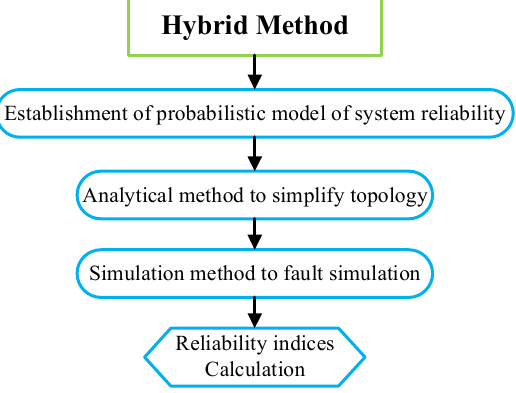
Figure 5. Flow chart of the hybrid